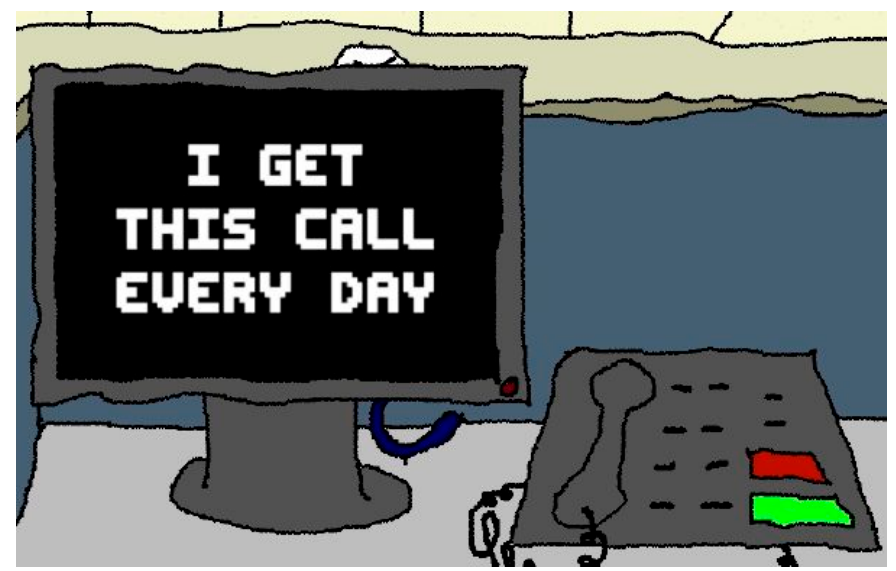
Figure 2. The opening screen for I Get This Call Every Day places the player in a first-person perspective at a call desk.